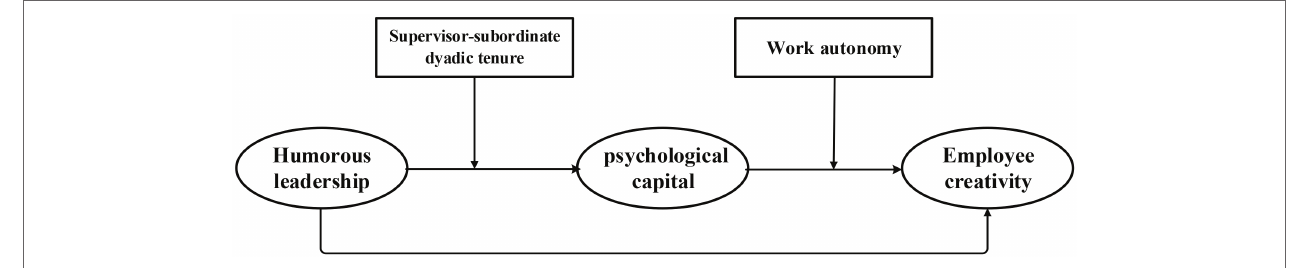
FIGURE 1 | Hypothesized